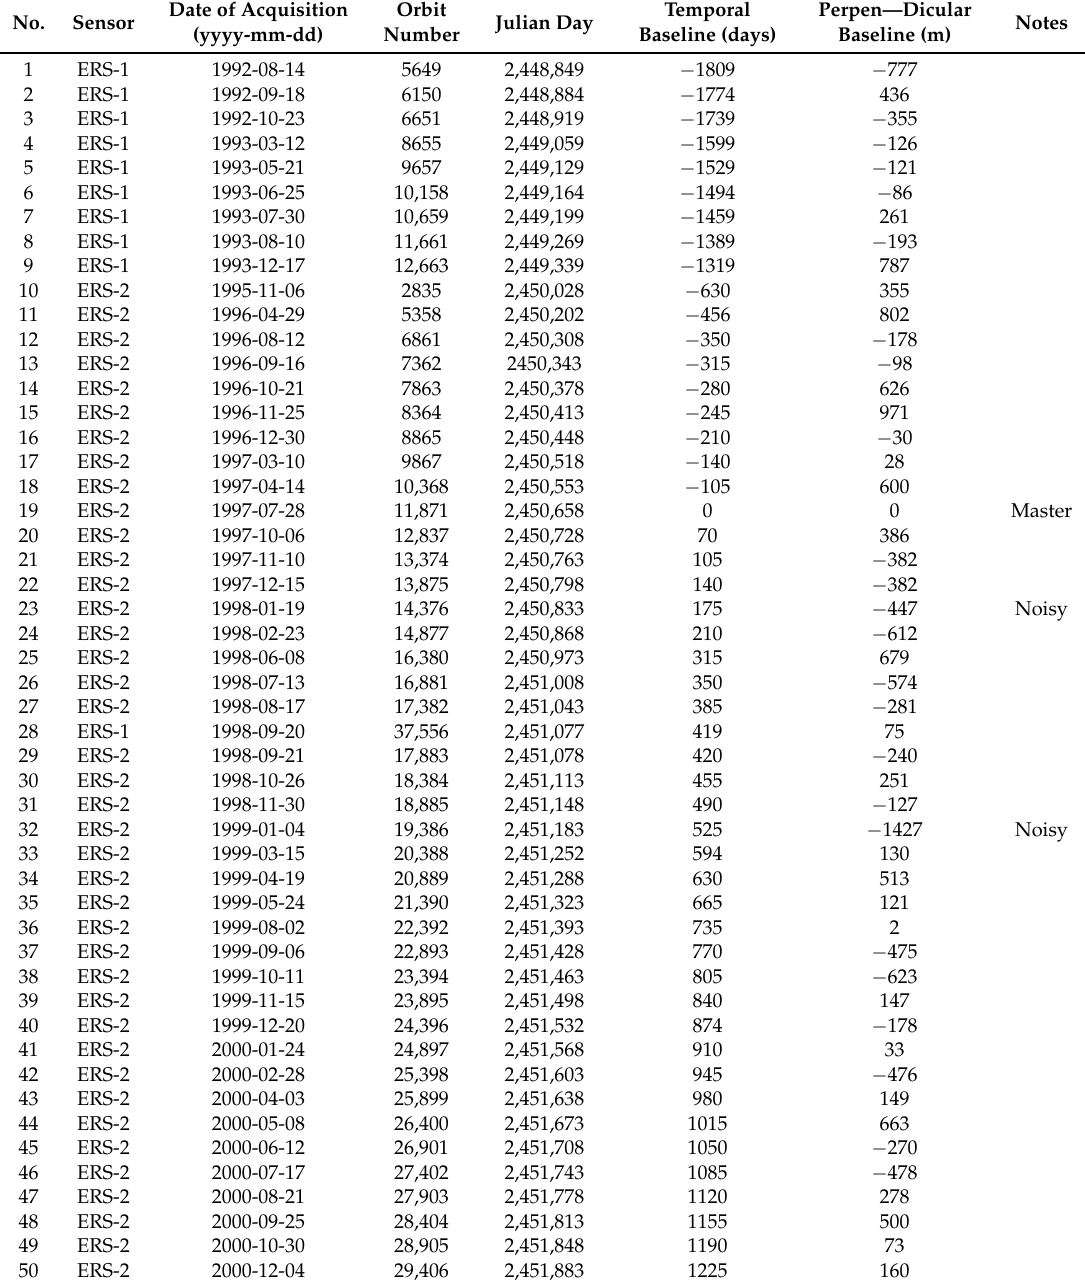
Table 1. ERS dataset. Track 494, frame 2889 descending. Images denoted in the NOTES column as noisy are those that have been removed from the final iteration due to the strong presence of atmospheric disturbances. Image denoted with MASTER is the reference images from which all the interferograms have been